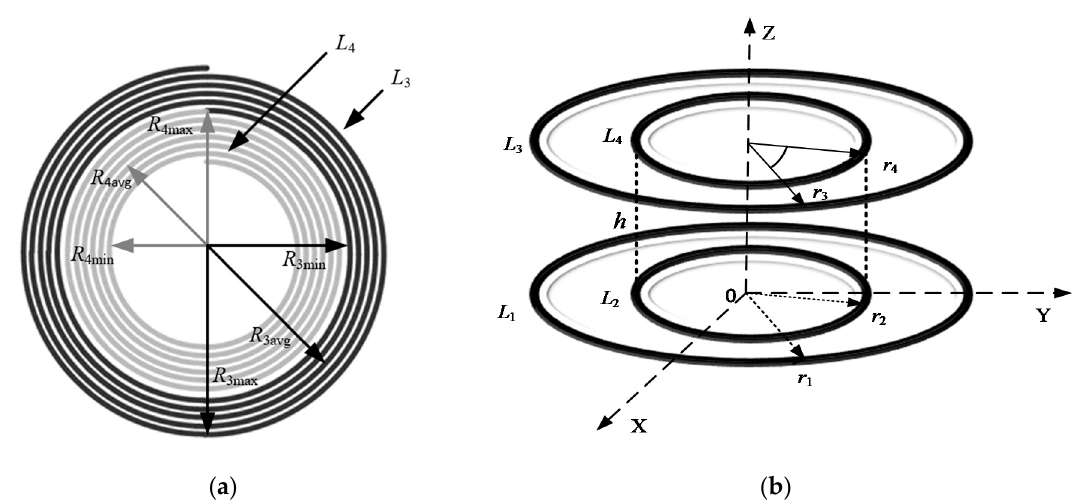
Figure 6. Parameter with coils. ( a ) Coil structures. ( b ) Space positions in the proposed structure.